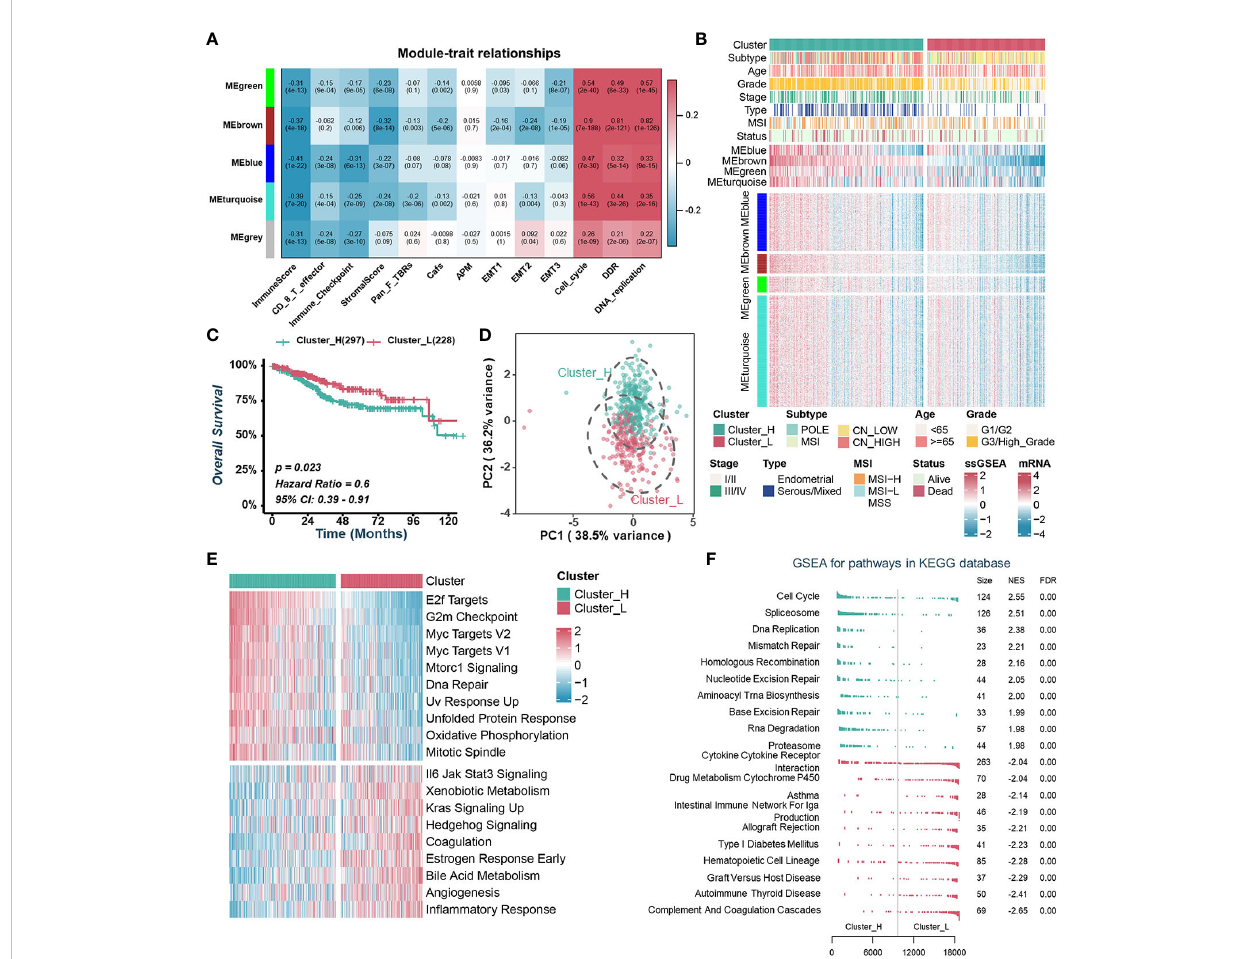
FIGURE 1 Identi fi cation of endometrial carcinoma subtypes based on WGCNA and consensus clustering. (A) . Heatmap of the correlation between module eigengenes with tumor microenvironment-related signatures or biological characteristics of tumor cells. (B) . Heatmap illustrating the expression pattern of CRs and the ssGSEA scores of modules between different clusters. (C) . Kaplan – Meier curve of OS between two TCGA-UCEC clusters. (D) . Principal component analysis to differentiate Cluster_H from Cluster_L. (E) . GSVA analysis of Hallmark gene sets in Cluster_H and Cluster_L. (F) . GSEA analysis of KEGG pathway gene sets in Cluster_H and